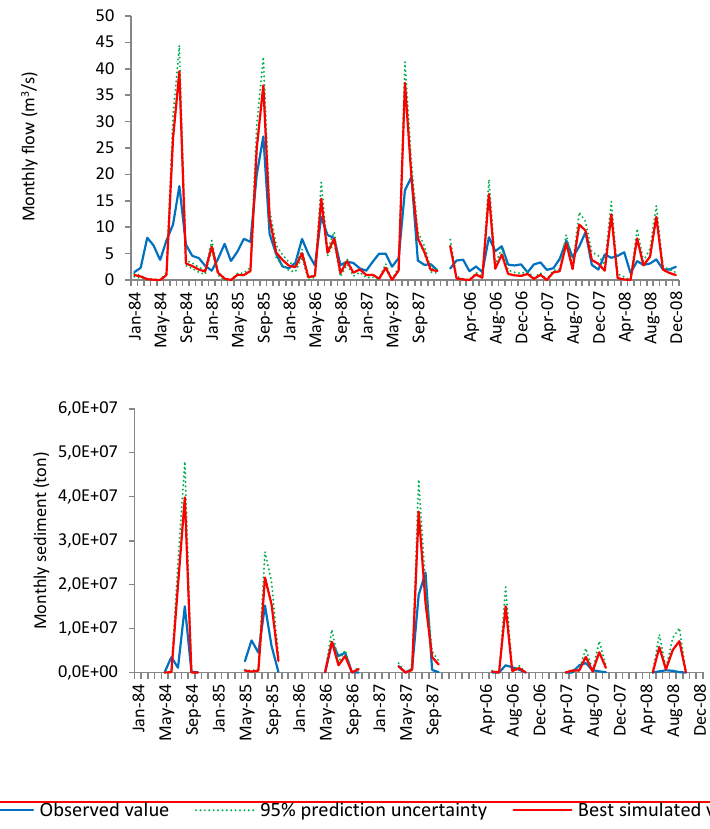
Fig. 4. Simulation results in 1980s and 2000s.